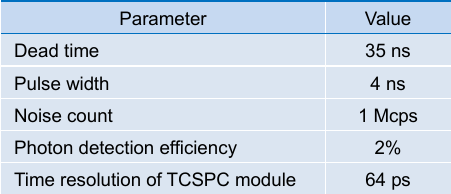
Table 1 | Main parameters of the Lidar system.